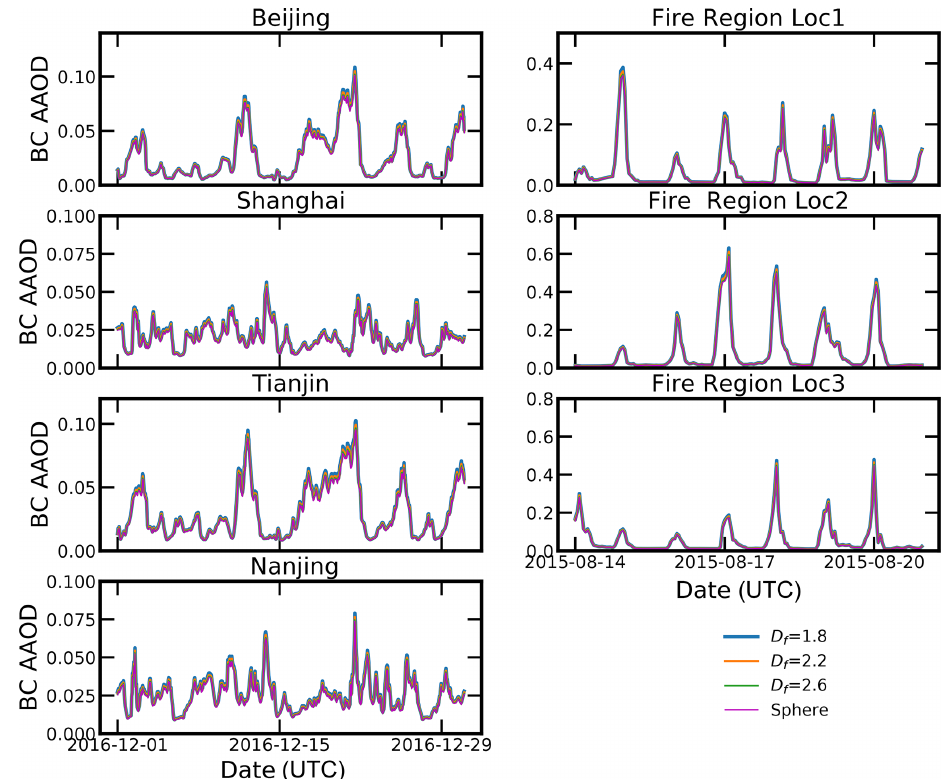
Figure 7. The comparison of BC AAOD for different BC morphologies, λ = 450nm.